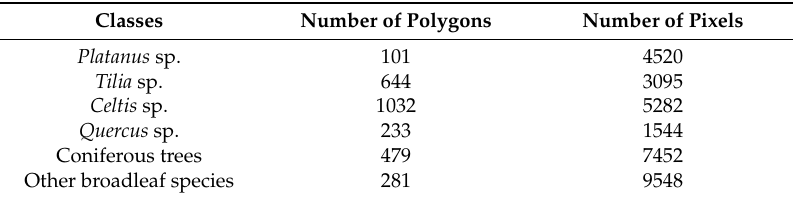
Table 2. Reference samples from June to August 2016 and June